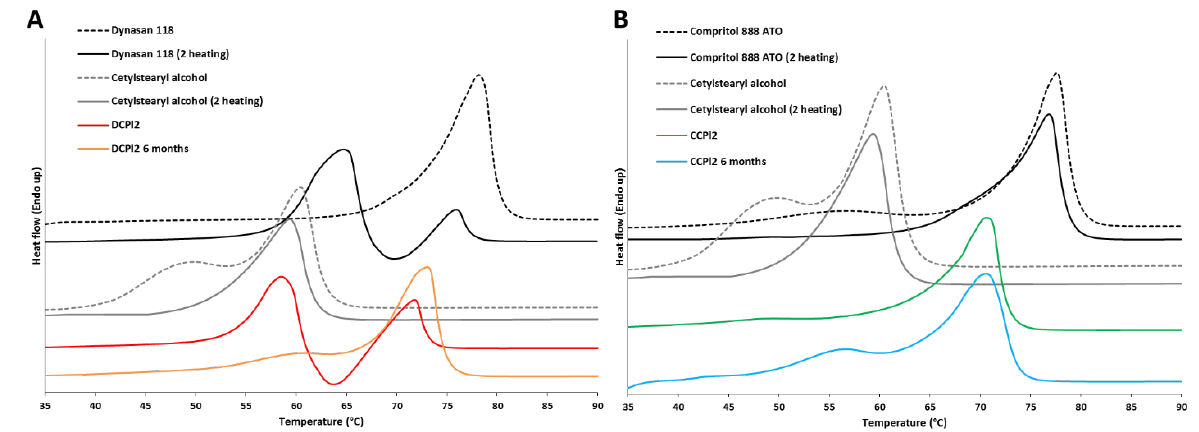
Figure 5. Thermograms of DCPl2 b-MPs immediately after production and after 6 months storage compared to the respective solid raw excipients (Dynasan 118 and cetylsearyl alcohol) subjected to two consecutive heating scans ( A ). Thermograms of CCPl2 b-MPs immediately after production and after 6 months storage compared to the respective solid raw excipients (Compritol 888 ATO and cetylsearyl alcohol) subjected to two consecutive heating scans ( B